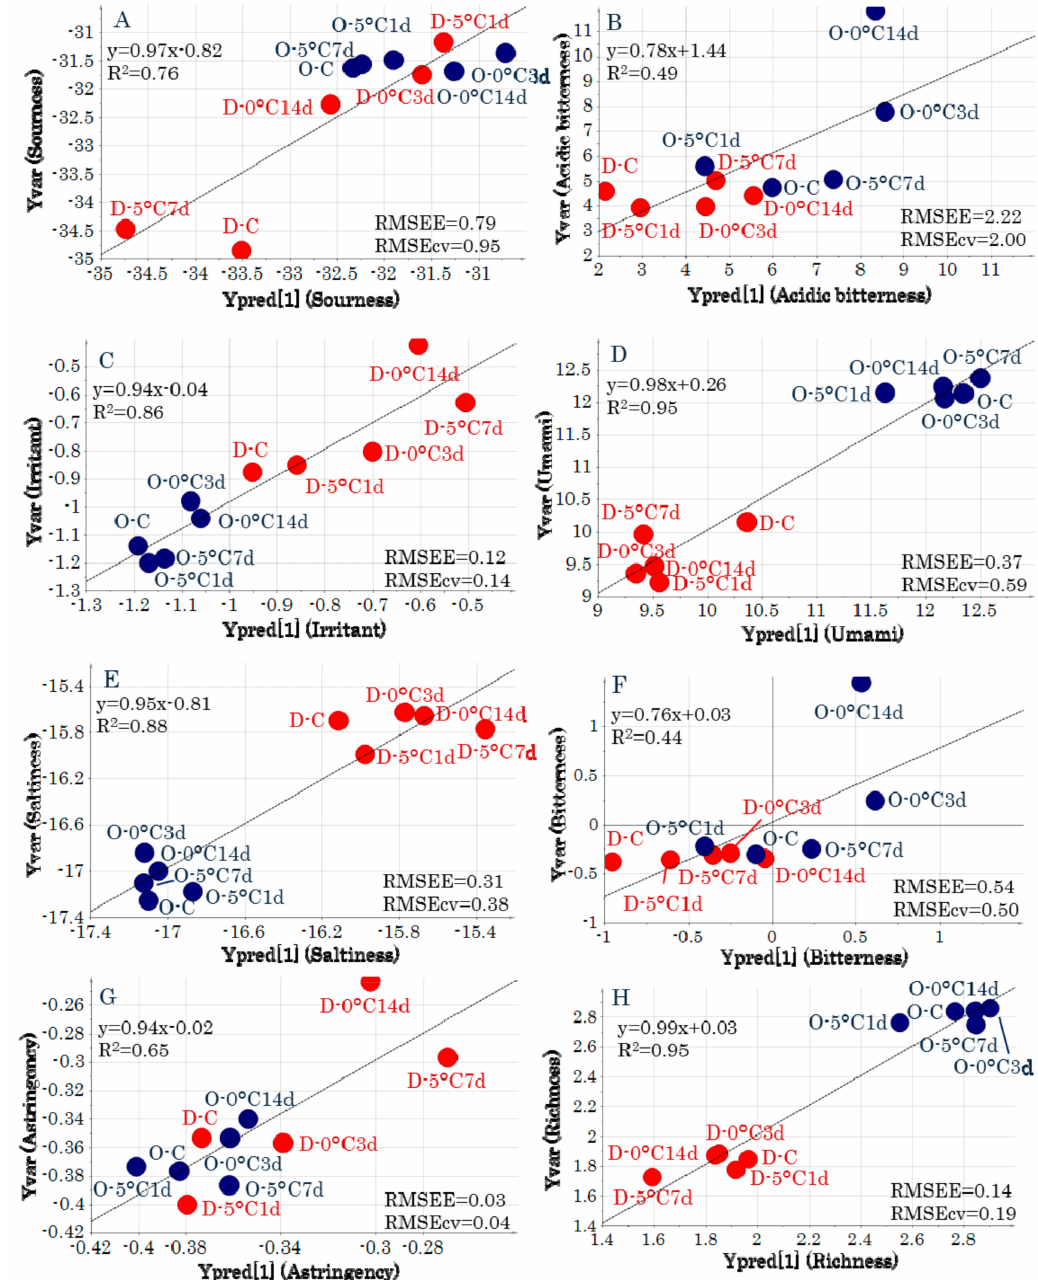
Figure 5. Regression analyses of the predictive model for each y variable. ( A ) Sourness. ( B ) Acidic bitterness. ( C ) Irritant. ( D ) Umami. ( E ) Saltiness. ( F ) Bitterness. ( G ) Astringency. ( H ) Richness. Symbols indicate sample IDs (Table S1). RMSEE , root mean square errors of estimation; RMSEcv , root mean square errors of